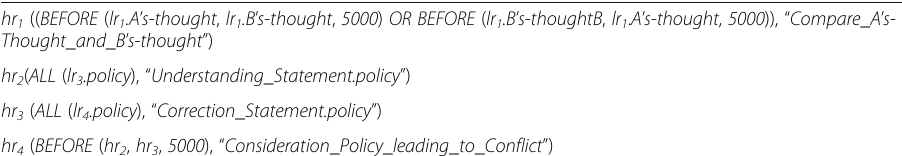
Table 4 Higher-level interpretation